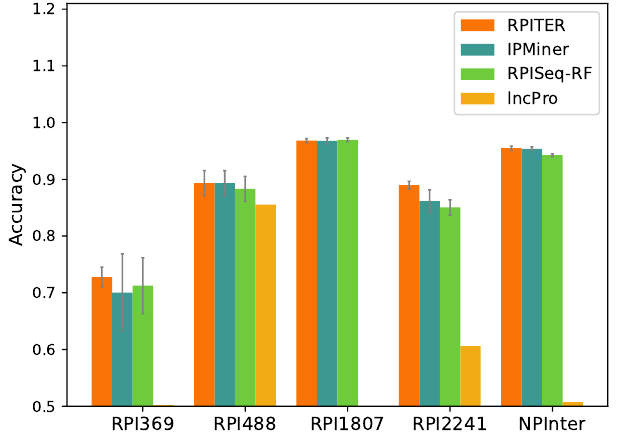
Figure 5. Performance comparison among different RNA–protein interaction (RPI) prediction methods on datasets RPI369, RPI488, RPI1807, RPI2241 and